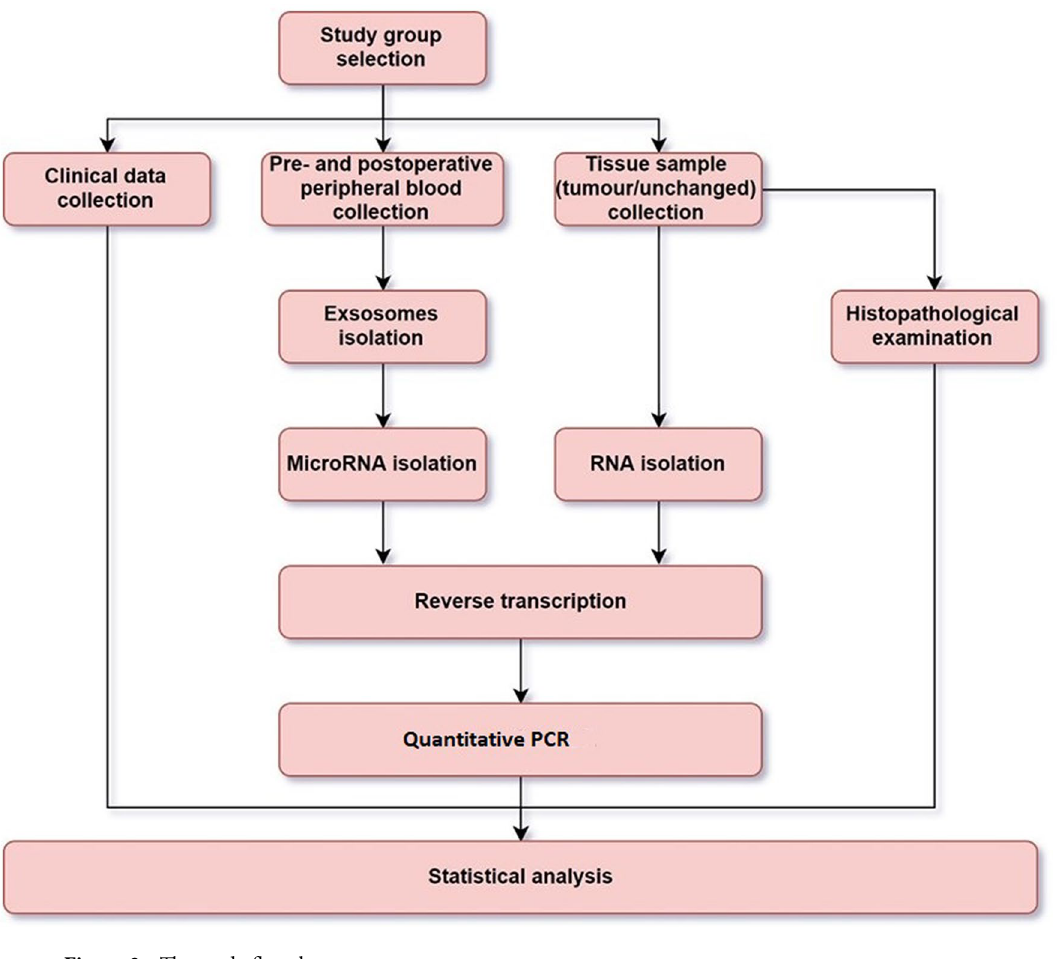
Figure 3. The study